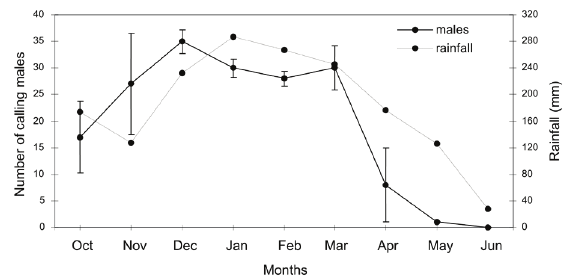
Figure 3 - Seasonal distribution of the mean number of male Allobates subfolionidificans in calling activity in relation to monthly precipitation from October 2002 to June 2003. Vertical bars indicate standard